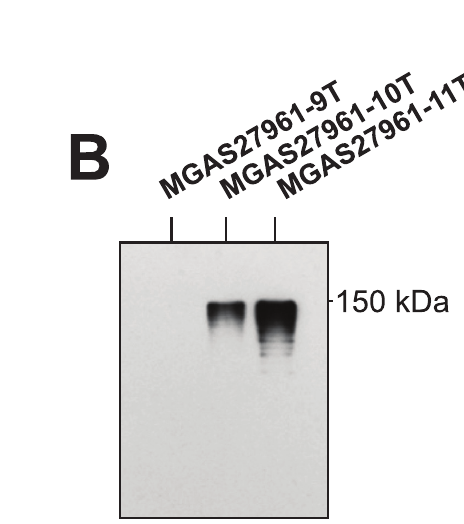
Fig 6. Western immunoblot analysis of Spy1336/R28. Isogenic strains were collected at mid-exponential phase (OD 600 = ~0.6). Whole cells were assayed for the presence of immunoreactive R28 protein with an anti-R28 polyclonal antibody [38]. (A) Isogenic deletion mutants assayed with anti-R28. (B) Isogenic HT size variant mutants assayed with anti-R28. 10% polyacrylamide gels were Spy1336-7